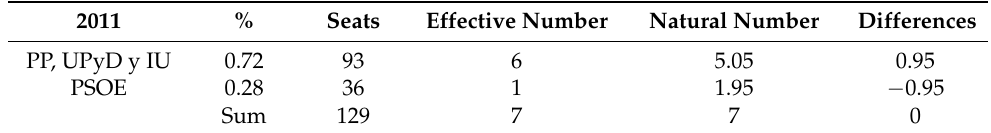
Table 8. Absolute disproportionality